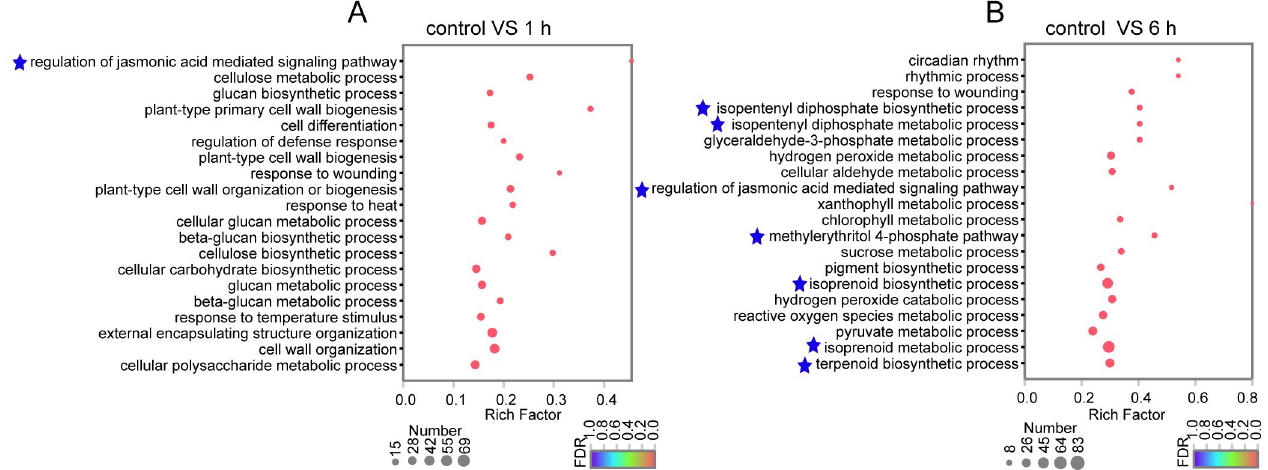
Fig 3. GO enrichment analysis of DEGs in C . wenyujin with MeJA-treatment for “control vs 1 h” (A) and “control vs 6 h” (B) groups. The y-axis on the right side represents the GO terms and x-axis represents rich factor. The size of the dot indicates the number of genes in this GO term, and the color of the dot corresponds to different FDR ( p -vaule). p -vaule < 0.05 indicates significant enrichment of GO function. Top 20 of significant enrichment results are displayed.